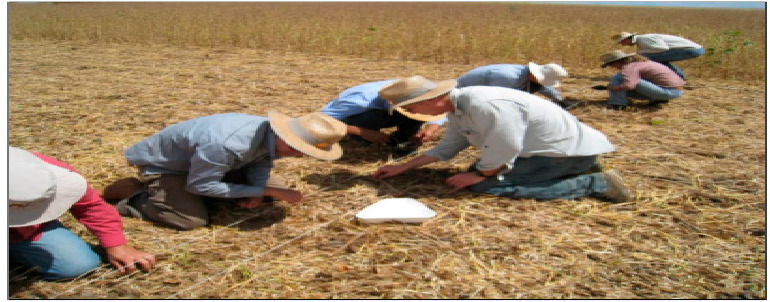
Figure 8. Picking grain losses in a 2-m 2 area [28].